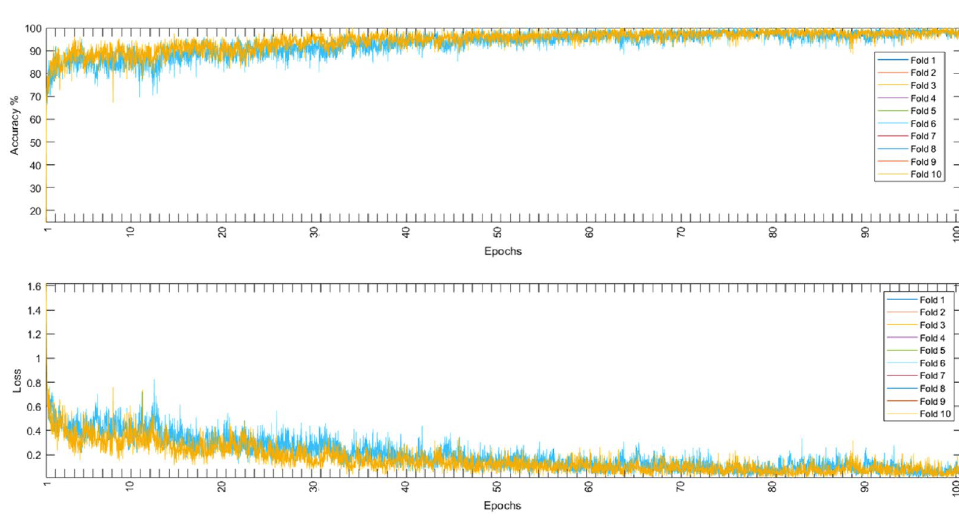
Figure 10. Augmented training accuracy and